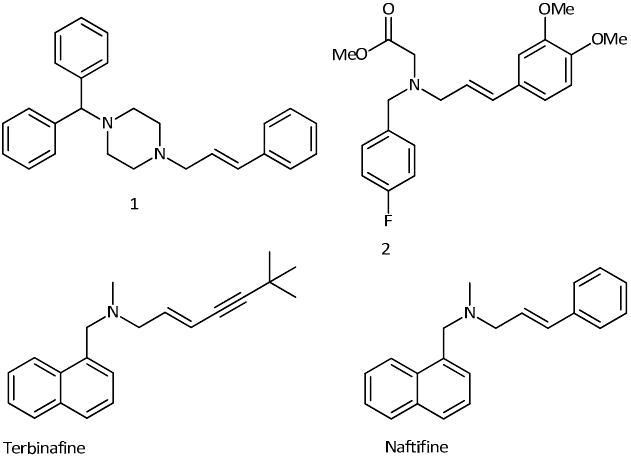
Figure 1. Some allylamines with important biological activities.